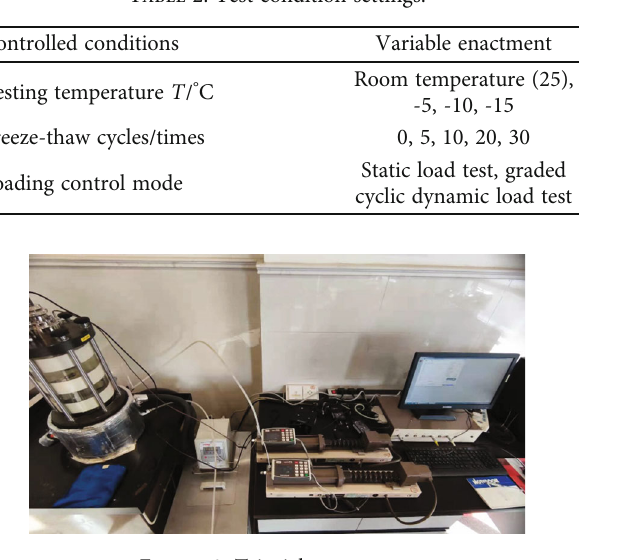
Table 2: Test condition settings.